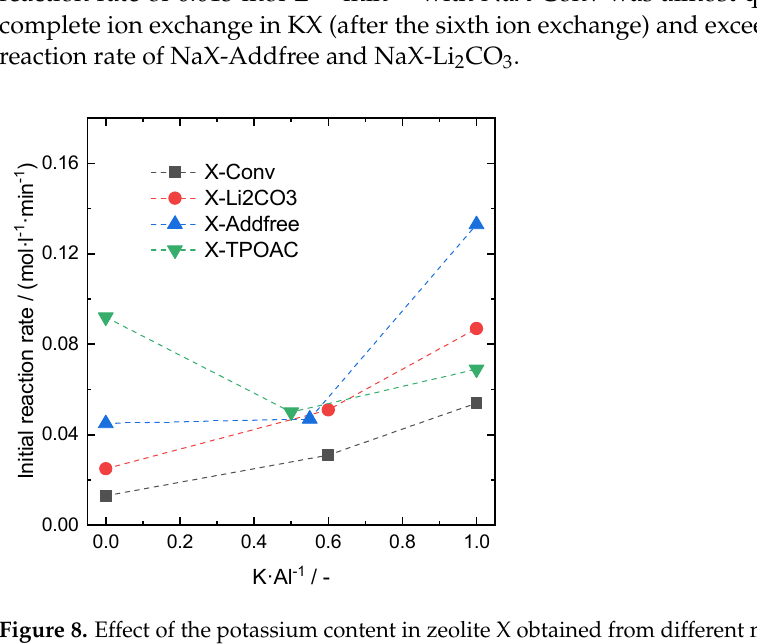
Figure 8. Effect of the potassium content in zeolite X obtained from different morphology modifying synthesis pathways on the initial reaction rate in the Knoevenagel condensation of ethyl cyanoacetate and benzaldehyde.